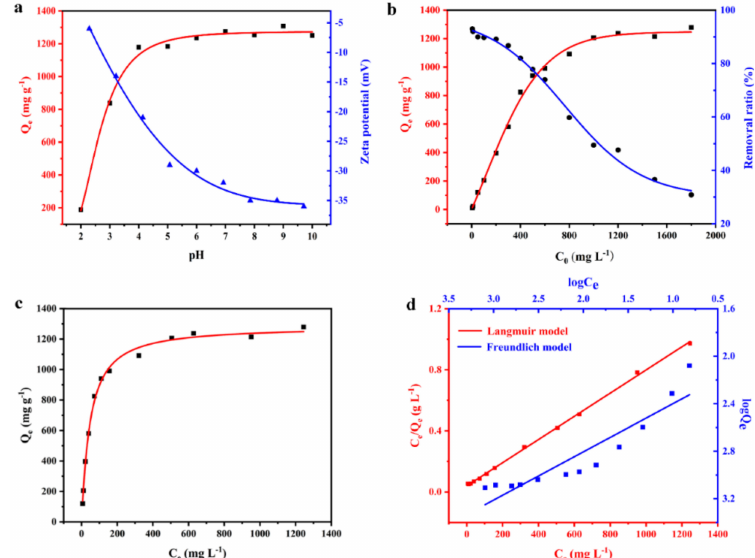
Figure 2. ( a ) The e ff ect of the initial pH value on adsorption capacities of AS for methylene blue (MB) removal and the pH dependence of Zeta potential variation of MB adsorbed onto AS; ( b ) the removal ratio of AS for MB at di ff erent initial MB concentrations; ( c ) the adsorption isotherm of AS for MB removal; ( d ) the fitting adsorption data for the Langmuir and the Freundlich isotherm